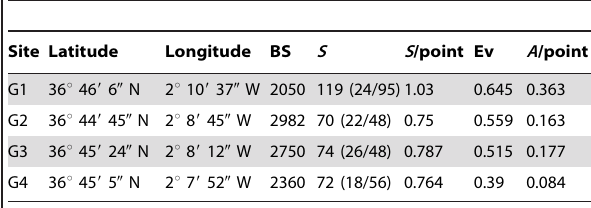
Table 2. Characteristics of study sites in Cabo de Gata-Nı´jar Natural